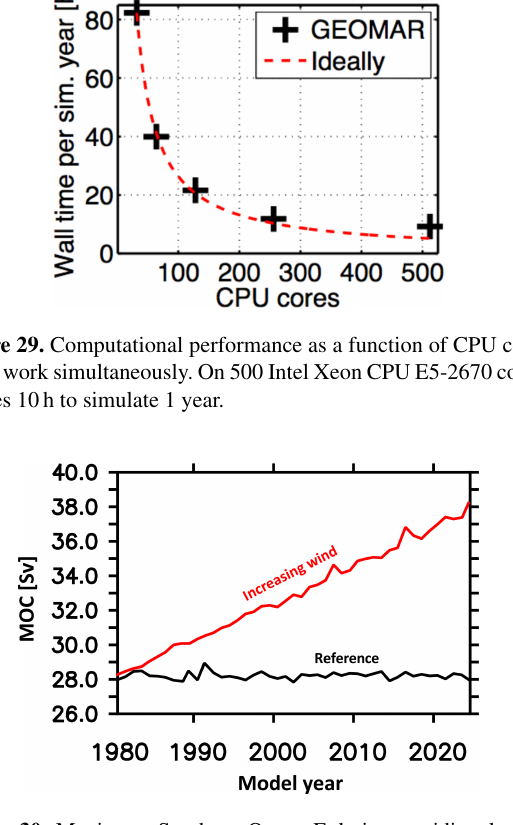
Figure 30. Maximum Southern Ocean Eulerian meridional over- turning circulation south of 40 ◦ S in units of 10 6 m 3 s − 1 . The black (red) line refers to the reference (increasing wind) simulation.